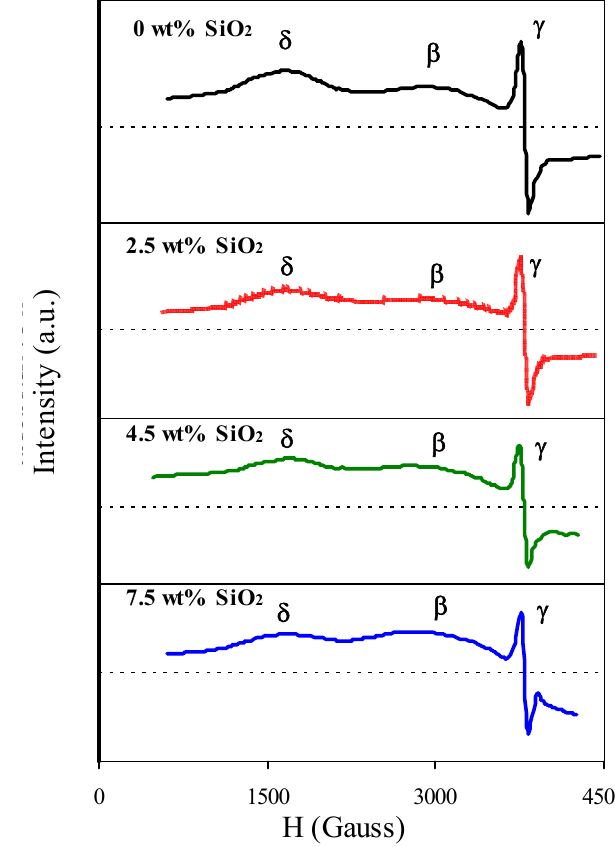
Figure 13. Electron paramagnetic resonance (EPR) spectra of catalysts.